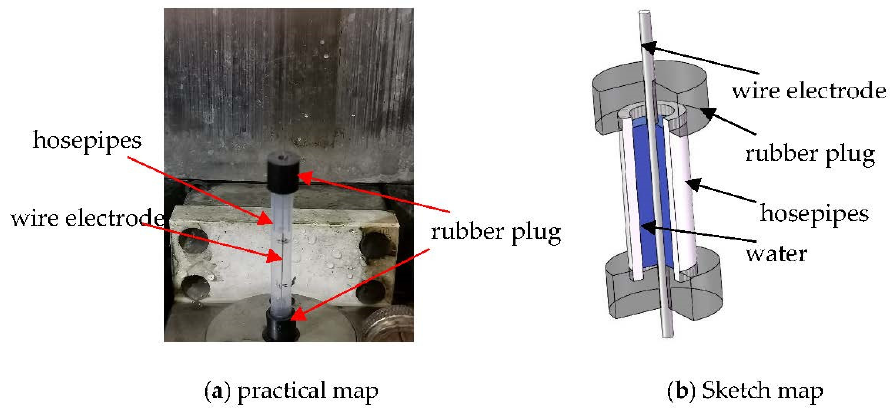
Figure 11. Depiction of the dielectric flow experiment by BWE and ZCSMWE.